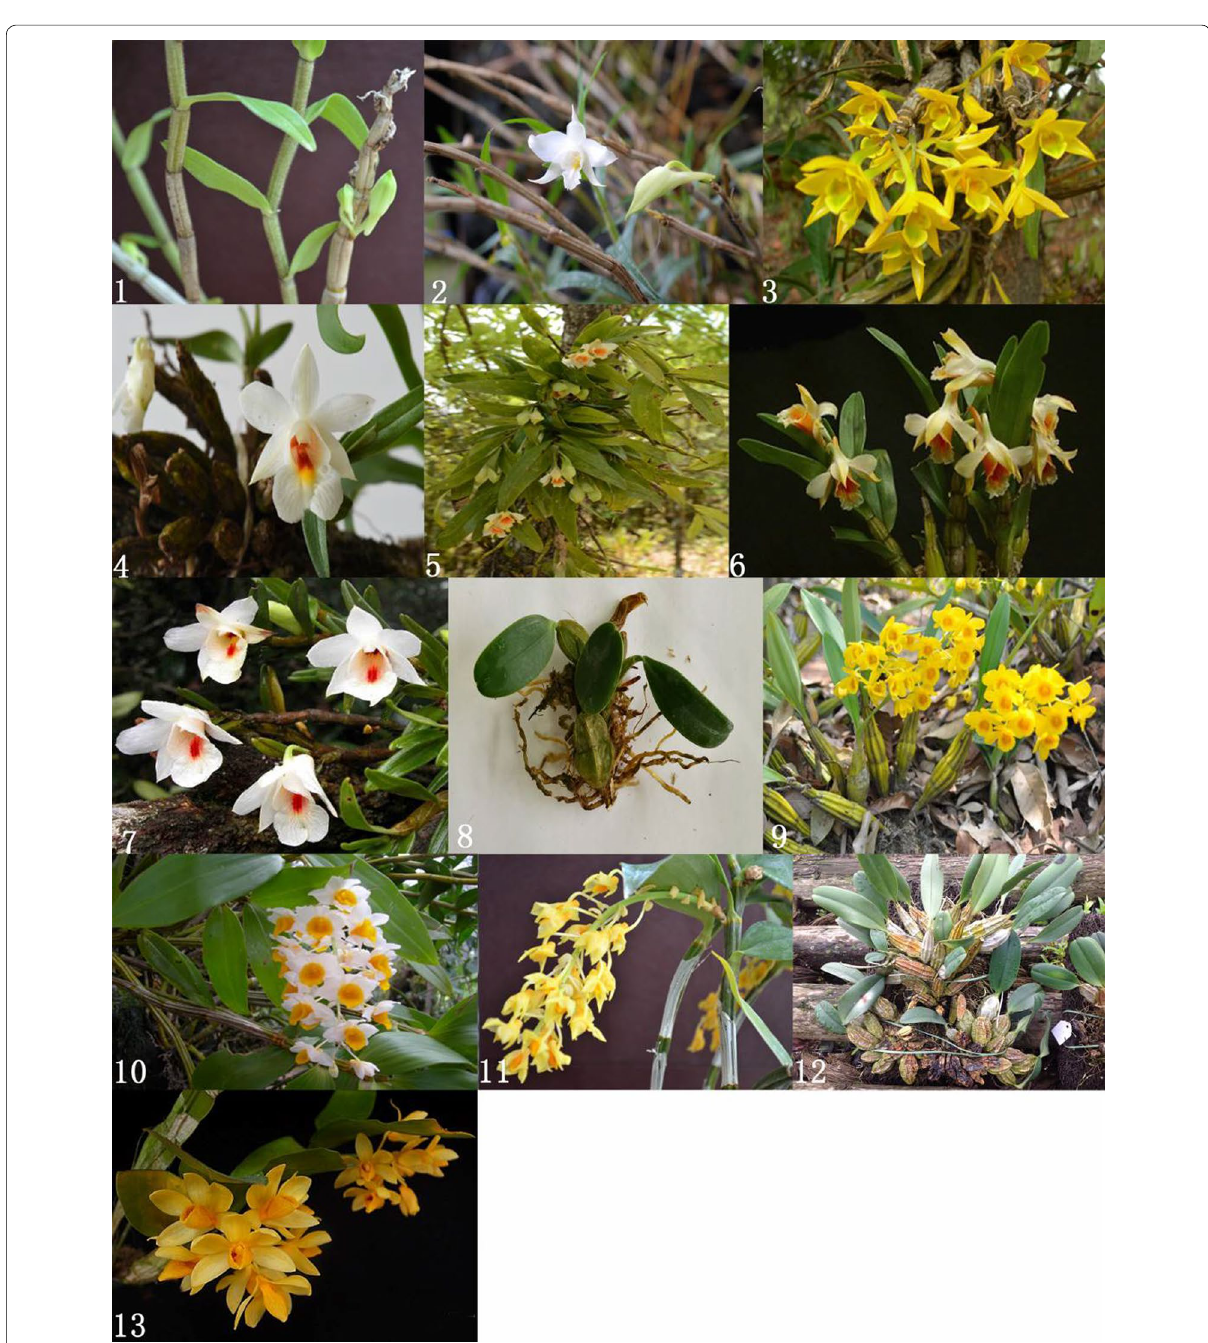
Fig. 1 The 13 tested Dendrobium species. 1, D. longicorna ; 2, D. infundibulum ; 3, D. trigonopus ; 4, D. bellatulum ; 5, D. williamsonii ; 6, D. cariniferum ; 7, D. sinense ; 8, D. jenkinsii ; 9, D. chrysotoxum ; 10, D. thyrsiflorum ; 11, D. densiflorum ; 12, D. lindleyi ; 13, D.